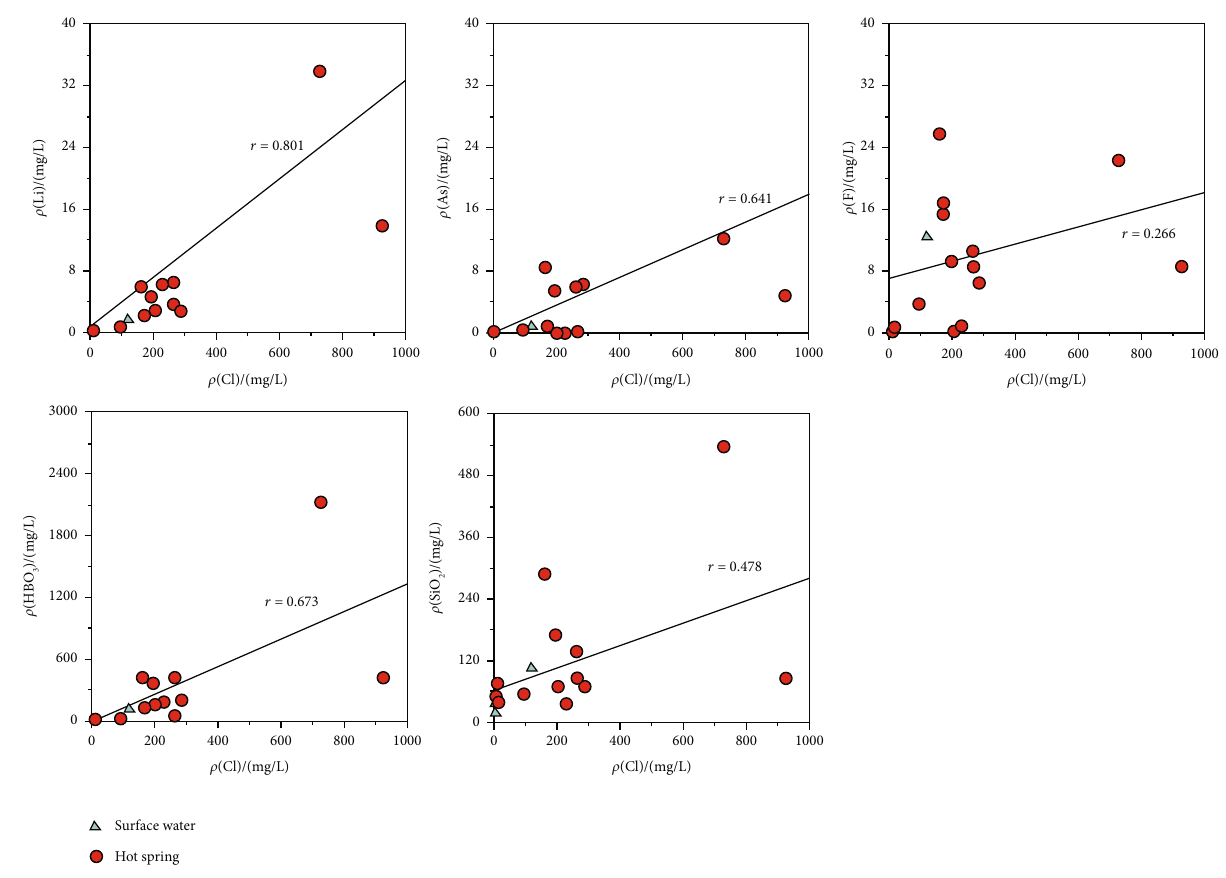
Figure 5: Correlation diagram between trace components and Cl − in the study area. Table 4: Data of δ 2 H – δ 18 O of the geothermal fl uid in the study